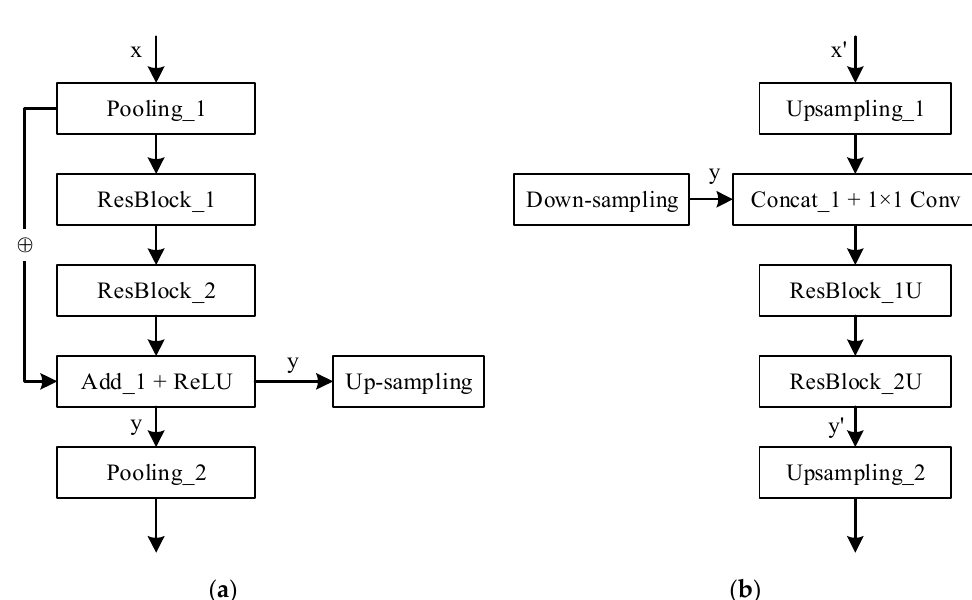
Figure 3. The details of the down-sampling ( a ) and up-sampling structures ( b ).